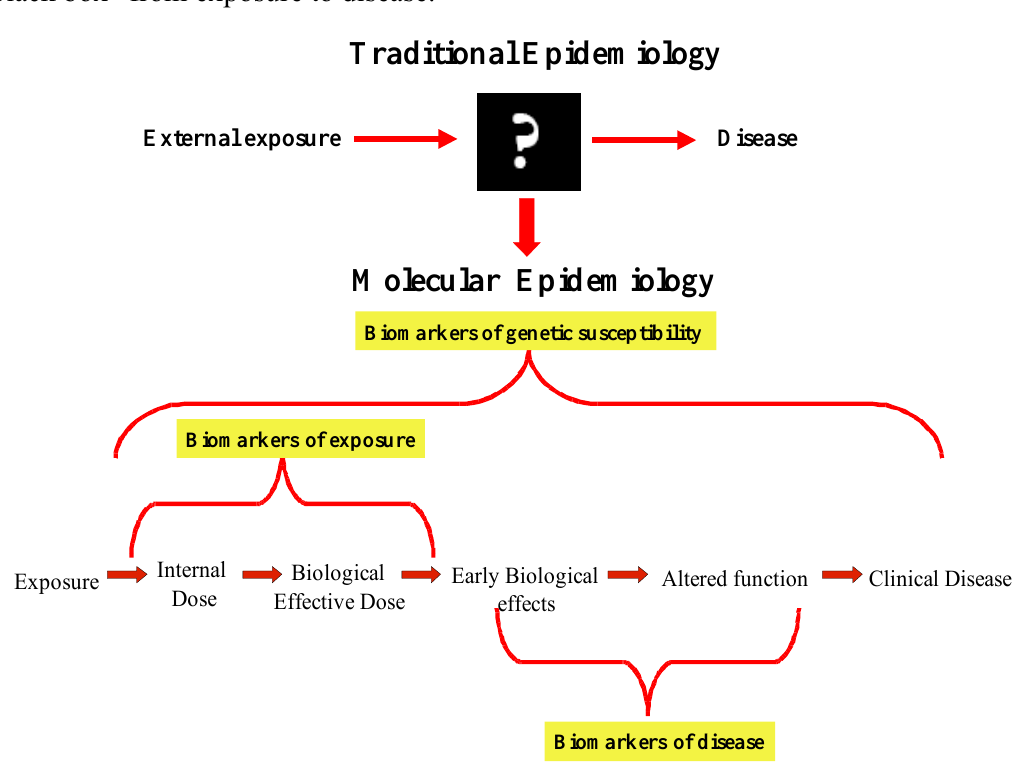
Figure 4. Biomarkers are the key elements of molecular epidemiology and may open the “black box” from exposure to